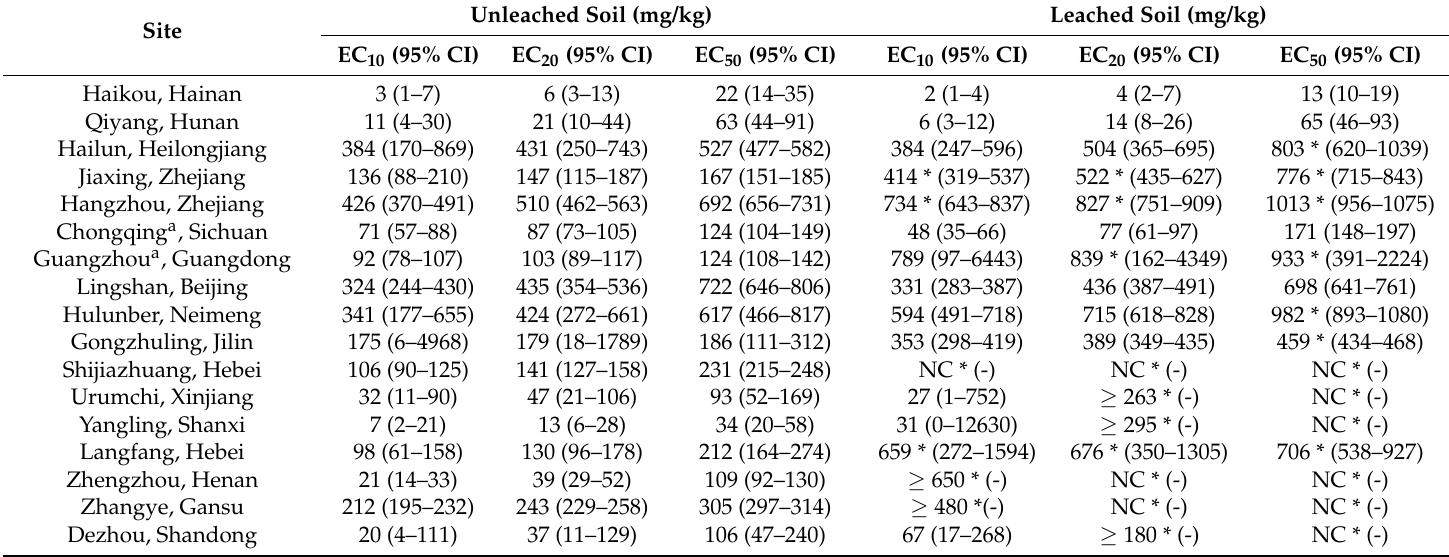
Table 2. Toxicity thresholds based on the concentrations of a single EDTA extractable Ni and barley root elongation in unleached and leached